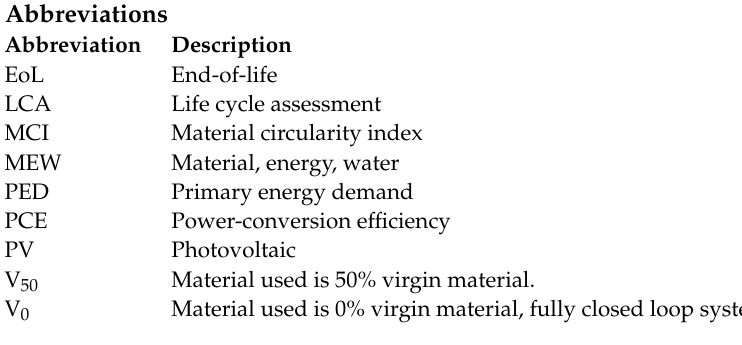
Table S2: Material circularity index I for the different PV modules and data required for their calcula- tion. References [35,42,65] are cited in the supplementary